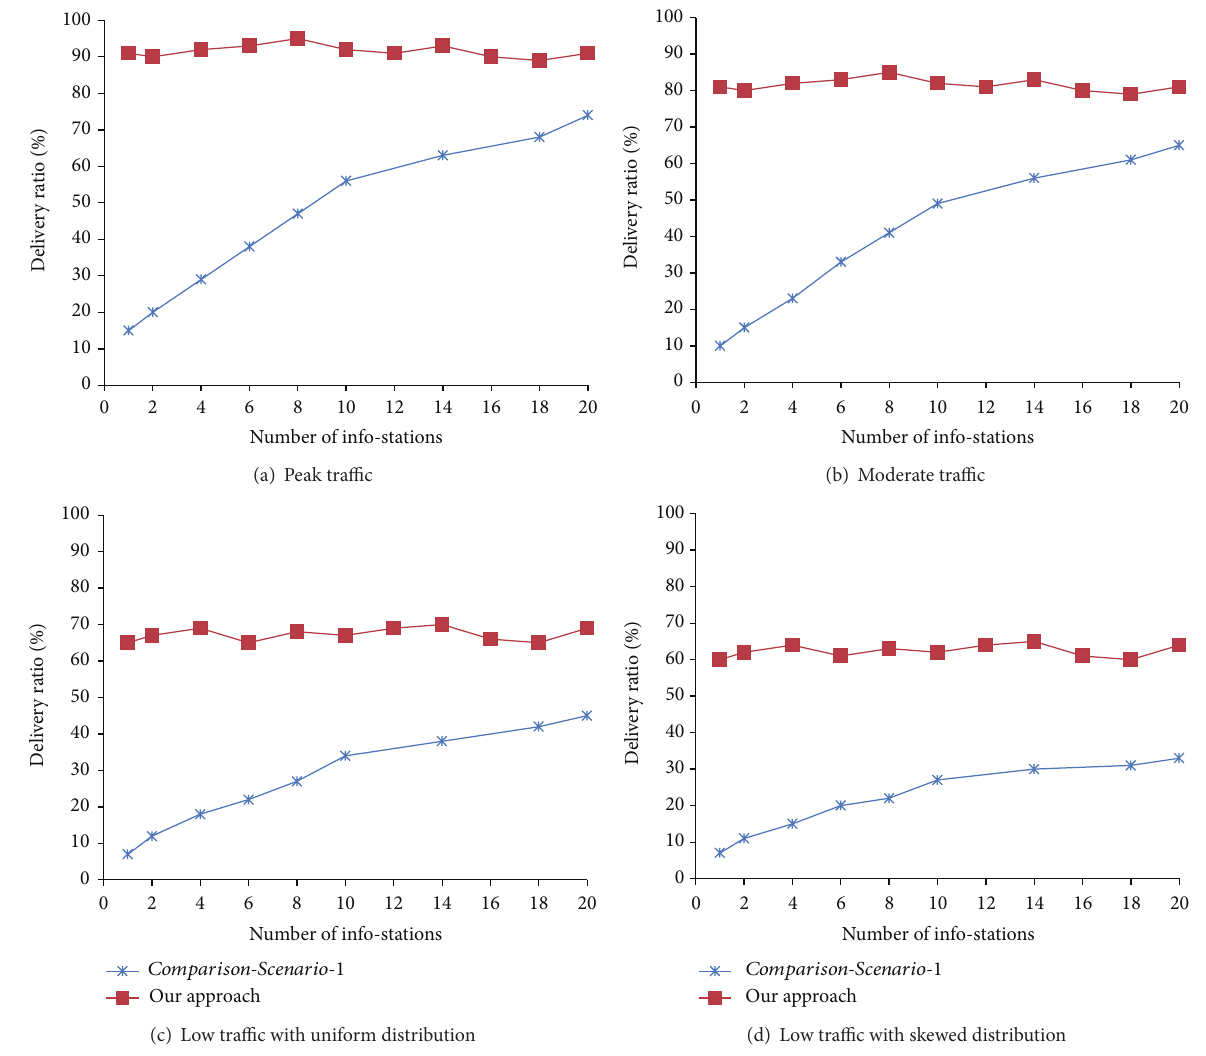
Figure 2: Delivery ratio: our approach versus Comparison-Scenario-1